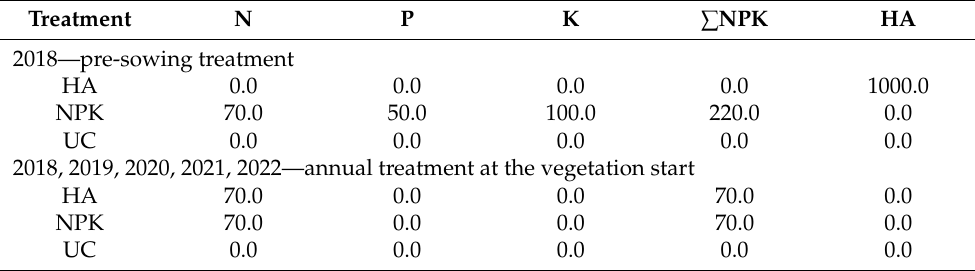
Table 3. The dosage of mineral nutrients NPK (kg ha − 1 , PK in oxide form) and humic preparation HA (HUMAC Agro, humic substances content of 62%) according to the